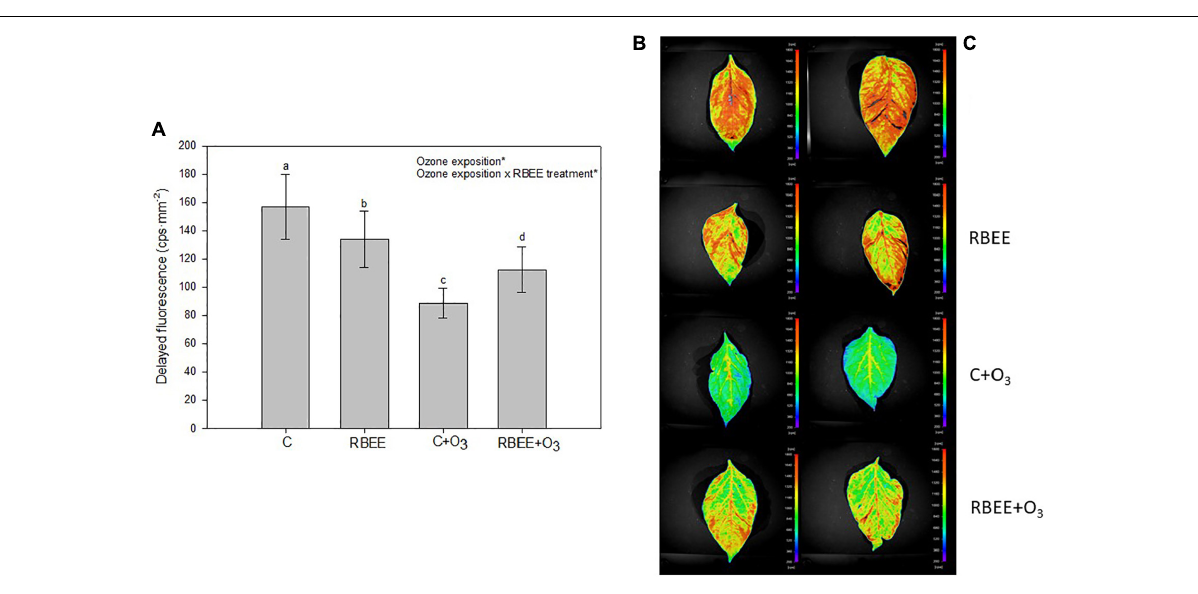
FIGURE 2 | Delayed fluorescence in leaves of pepper plants in response to two conditions of ozone (O 3 ) (0 and 100 ppm) under a treatment without and with rice bran enzymatic extract (RBEE). (A) Counts per second (cps) values for each treatment. Values represent mean ± SD, n = 5. Different letters indicate means that are significantly different from each other (two-way ANOVA, O 3 exposition × RBEE treatment; HSD test, P < 0.05). O 3 exposition and ozone exposition × RBEE treatment in the corner of the panel indicate main or interaction significant effects (* P < 0.0001); (B) photographs taken by the plant imaging system NightShade LB 985. The color scale mirrors the detected counts per second (cps) of delayed fluorescence emission in